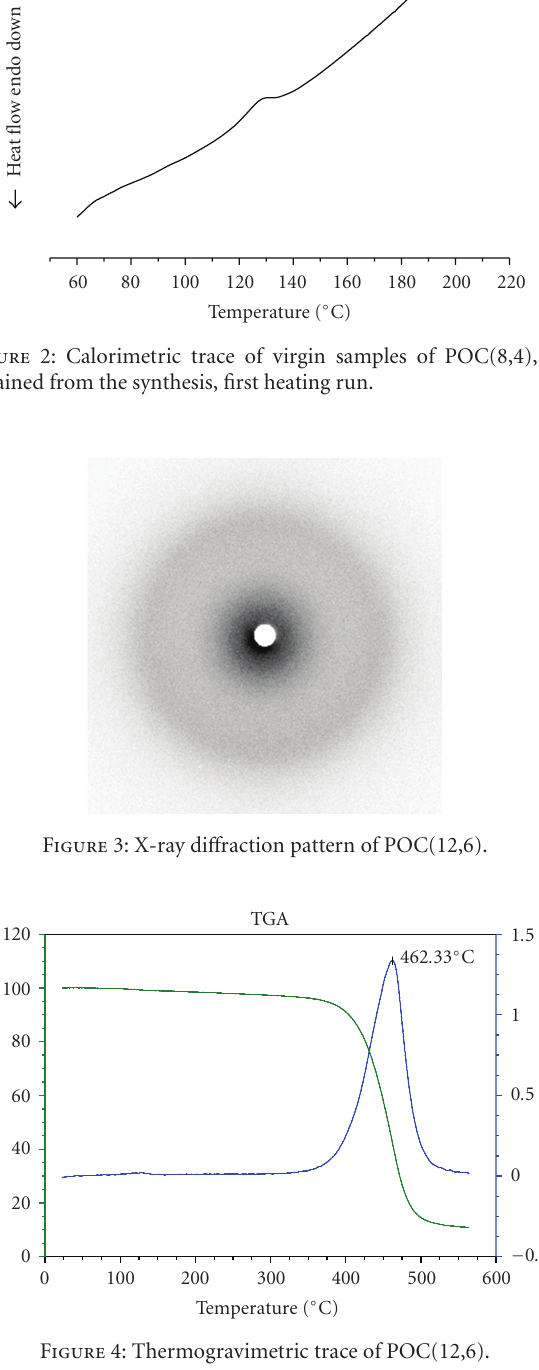
respect to the oxadiazole unit (two strong and broad peaks at 322 and 345 nm) and emits in the wavelength range (two strong peaks at 354 and 369 nm) where the oxadiazole unit strongly absorbs. The result is that POCs show a strong blue emission, identical to that of analogue oxadiazole-containing polymers; in particular, the emission occurs at 407 nm (main peak, sharp) and at 460 nm (lower peak, broad band).